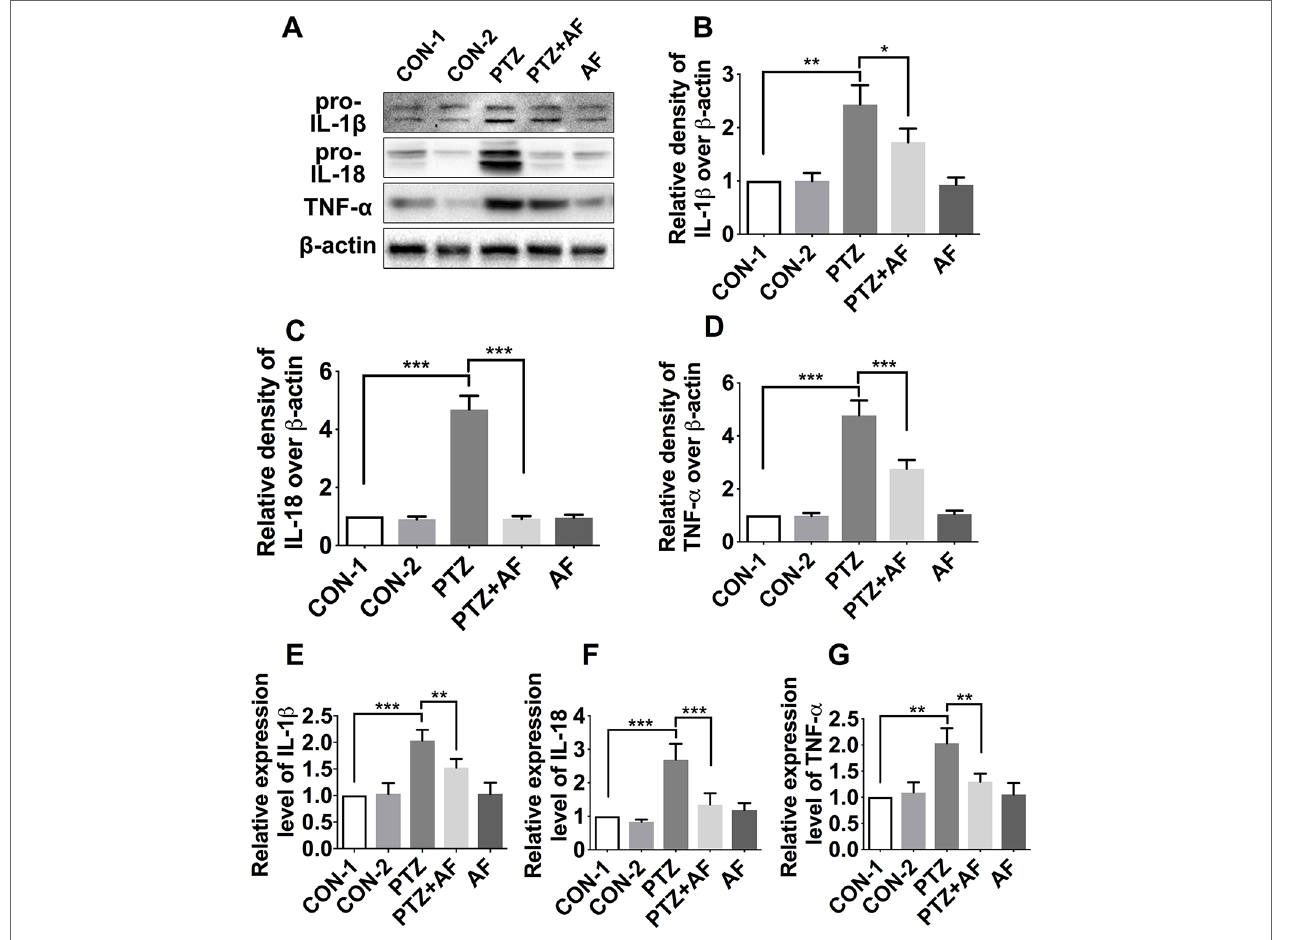
FIGURE 5 | Effects of amentoflavone on the expression of inflammatory cytokines in the hippocampus by PTZ-induced kindling. (A) Representative immunoblots of IL-1 β , IL-18, and TNF- α proteins in different groups. (B – D) Semi-quantitative analysis of the relative levels of IL-1 β , IL-18, and TNF- α by densitometric analysis ( n = 6 mice per group, Student’s t test ). (E – G) Semi-quantitative analysis of the relative levels of IL-1 β , IL-18, and TNF- α using ELISA ( n = 9 mice per group, Student’s t test ). Error bars represent mean ± s.d. *, **, *** represent p < 0.05, p < 0.01, p < 0.001, respectively. PTZ, pentylenetetrazole; AF,